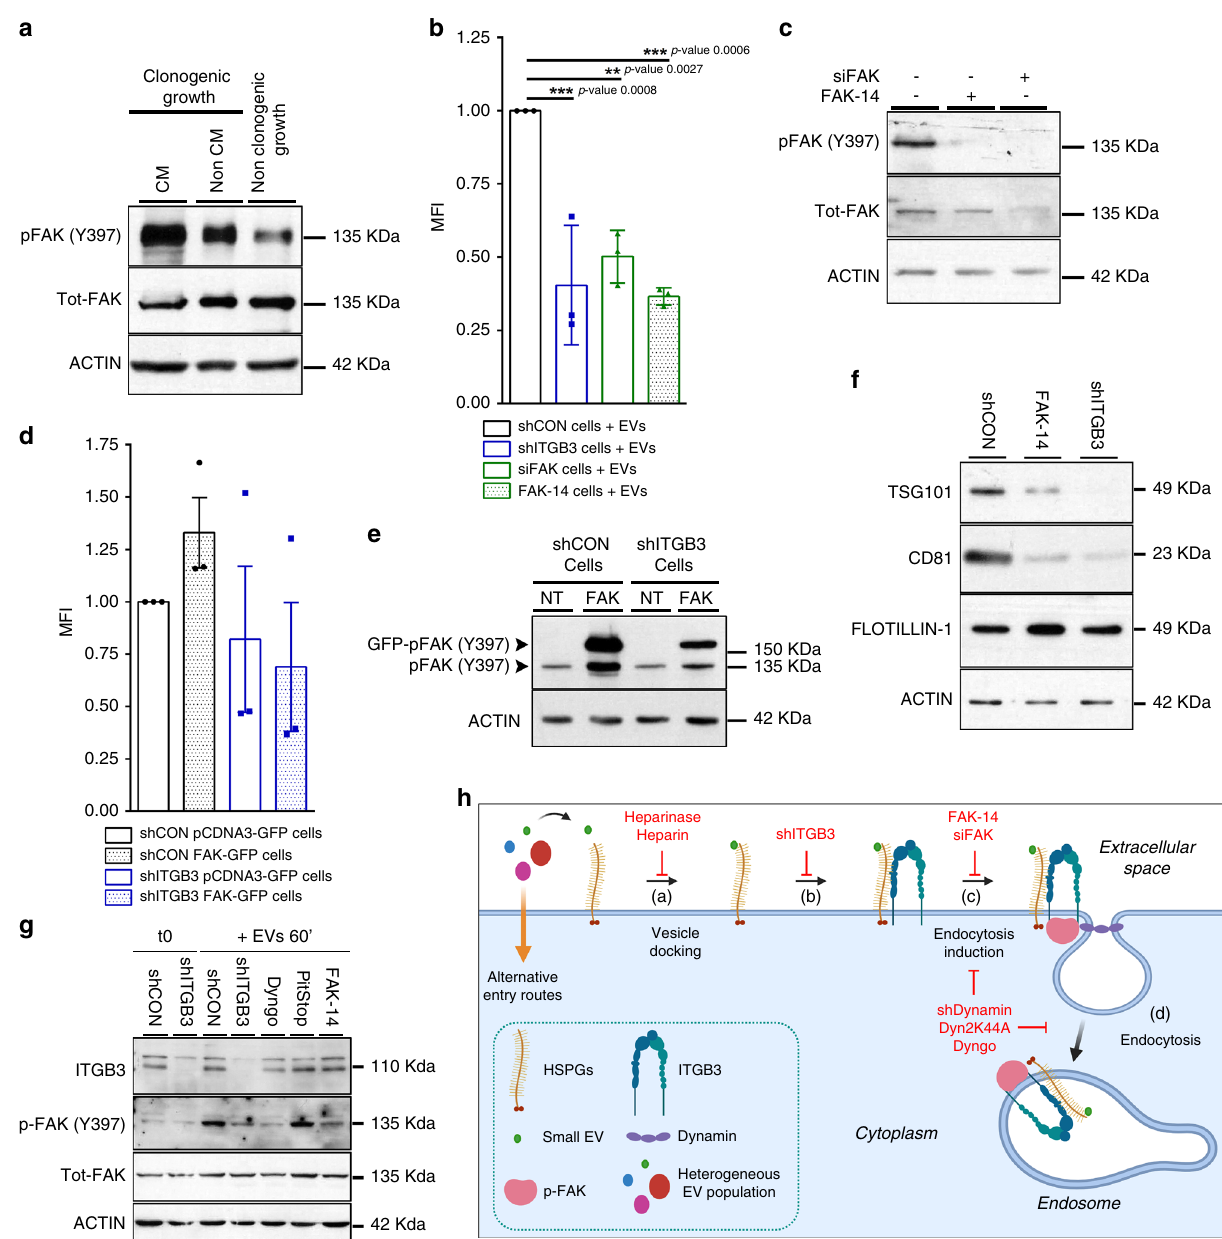
Fig. 6 EV-induced activation of FAK is required for ITGB3-dependent EV uptake. a Representative immunoblot analysis of pFAK activity either in normal conditions or clonogenic growth conditions with and without conditional medium (CM). b Internalization of 2 – 5 µ g mL − 1 PKH26-labelled exosomes derived from MDA.MB.231 cells by MDA.MB.231 shCON, shITGB3, siFAK or shCON pretreated with 15 µ M FAK 14 for 14 – 16h, measured by FACS. c